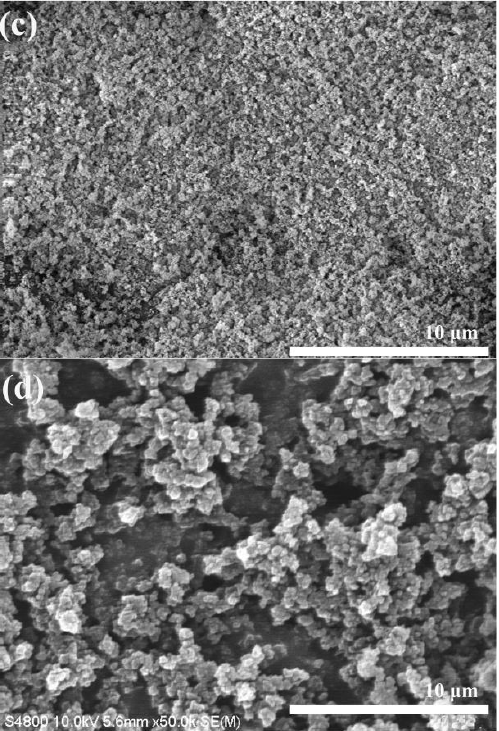
Figure 8. Micromorphology of the P 40 –P 4 –P 0.4 superhydrophobic coating before and after ( a , c ) 100 attrition cycles and ( b , d ) 96 h UV-light irradiation, the inset is the topography of the superhydrophobic surface before wear at higher magnification.